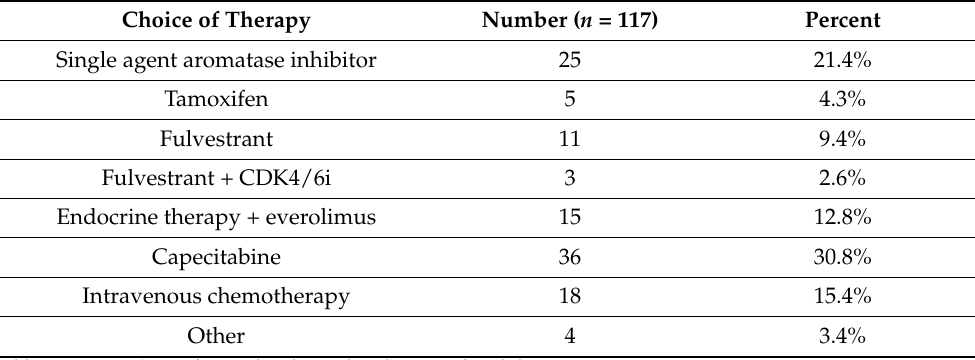
Table 3. Second-line